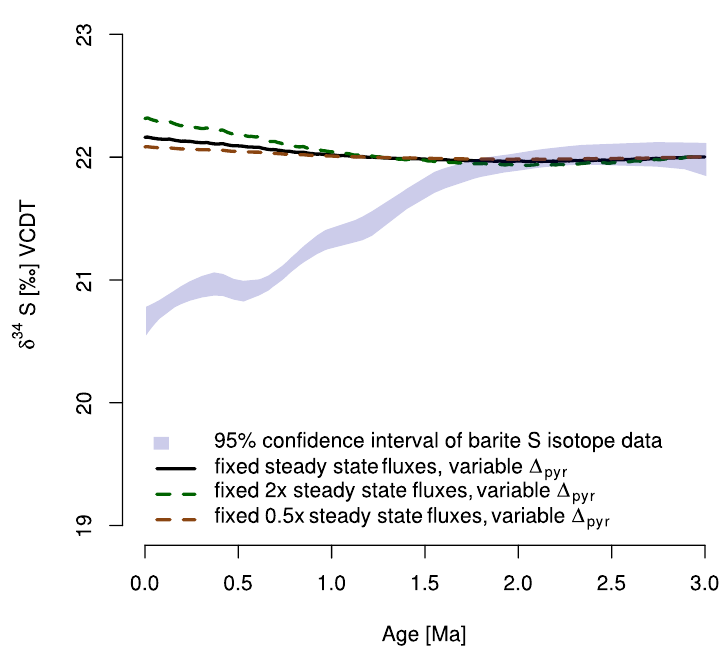
Figure A1. Model output using variable (cid:49) pyr . Black solid line – model output produced assuming constant steady state fluxes and variable (cid:49) pyr . Green dashed line – model output produced assuming constant fluxes at 200% steady state values and variable (cid:49) pyr . Brown dashed line – model output produced assuming constant fluxes at 50% steady state values and variable (cid:49) pyr . The shaded area represents the 95% confidence interval of a LOESS approximation of the “true” δ 34 S SO value. Note that the size of pyrite reservoir in these model experiments 4 remains the same because input and output fluxes are kept constant.